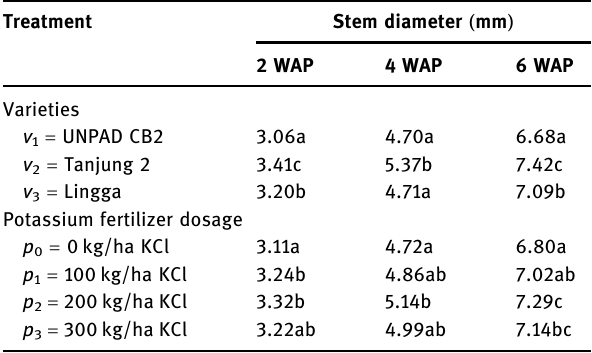
Table 4: E ff ect of potassium fertilizer dosage and red chili varieties on stem diameter at 2, 4, and 6 WAP